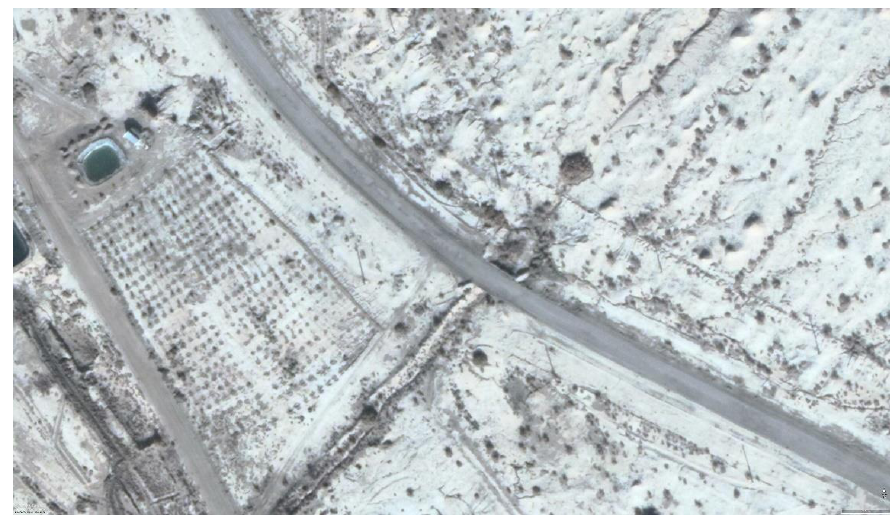
Appl. Sci. 2021 , 11 , x FOR PEER REVIEW Figure 16. The bridge No. 4 on Google Earth (Latitude: 35°32′28″ N, Longitude: 53°29′49″ E). Figure 16. The bridge No. 4 on Google Earth (Latitude: 35 ◦ 32 (cid:48) 28” N, Longitude: 53 ◦ 29 (cid:48) 49” E).